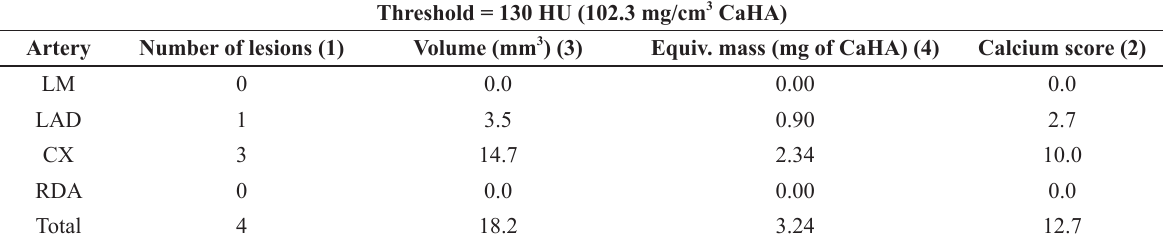
CAC score results for the participant with coronary artery calcification.